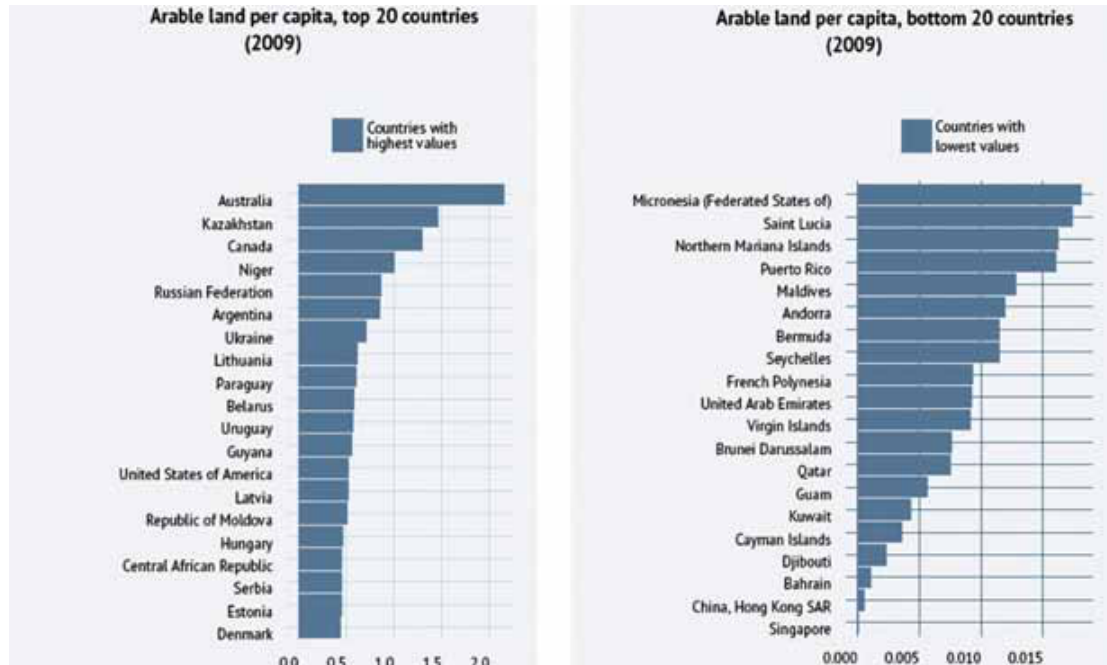
Figure 3 . Demonstration of uneven geographical distribution of arable land source: FAO,